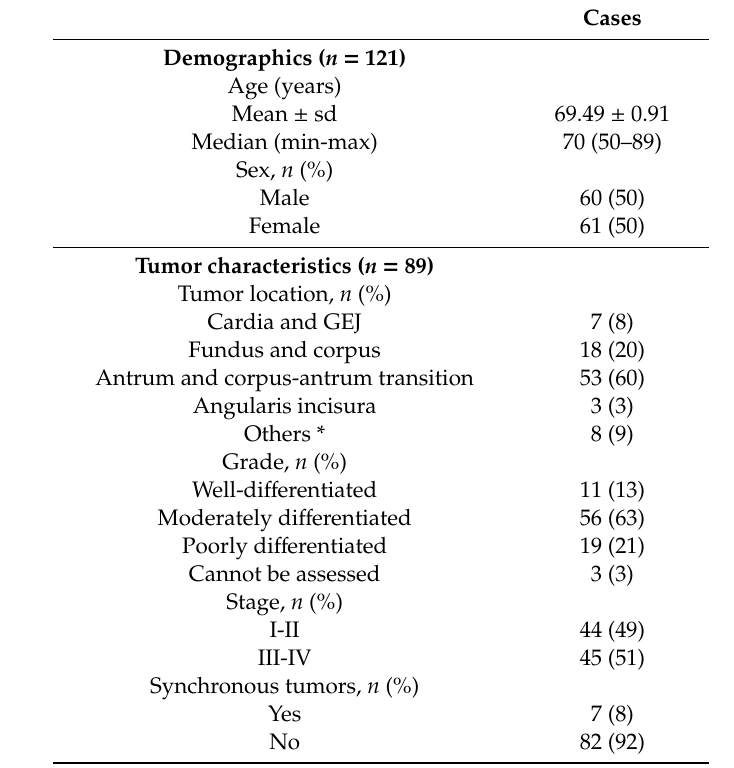
Table 1. Description of the